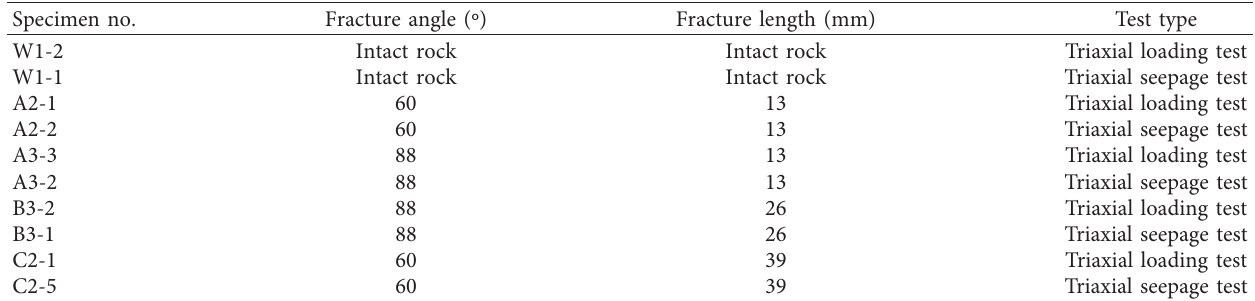
Table 3: The design of physical tests.